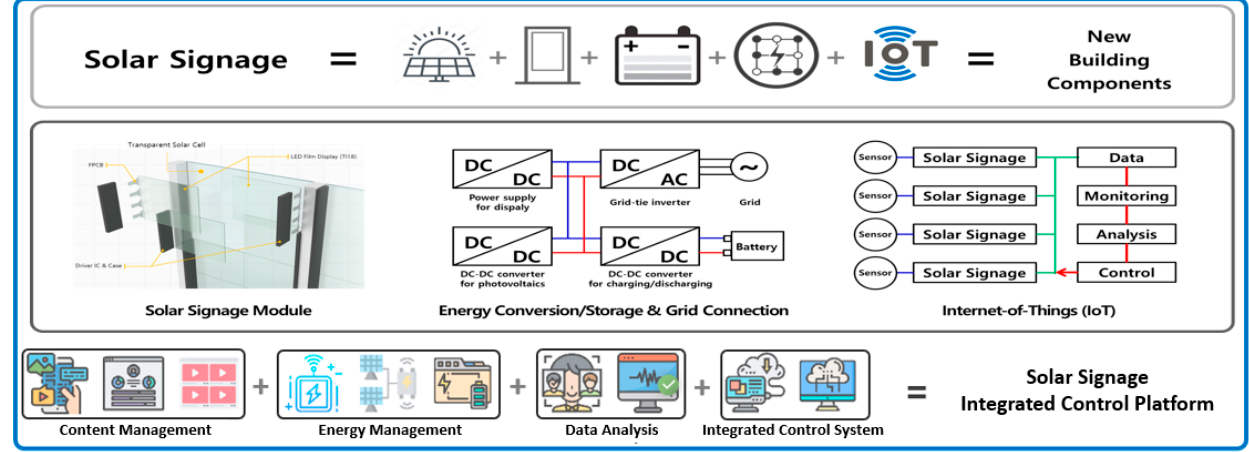
Figure 2. Conceptual map of solar signage.